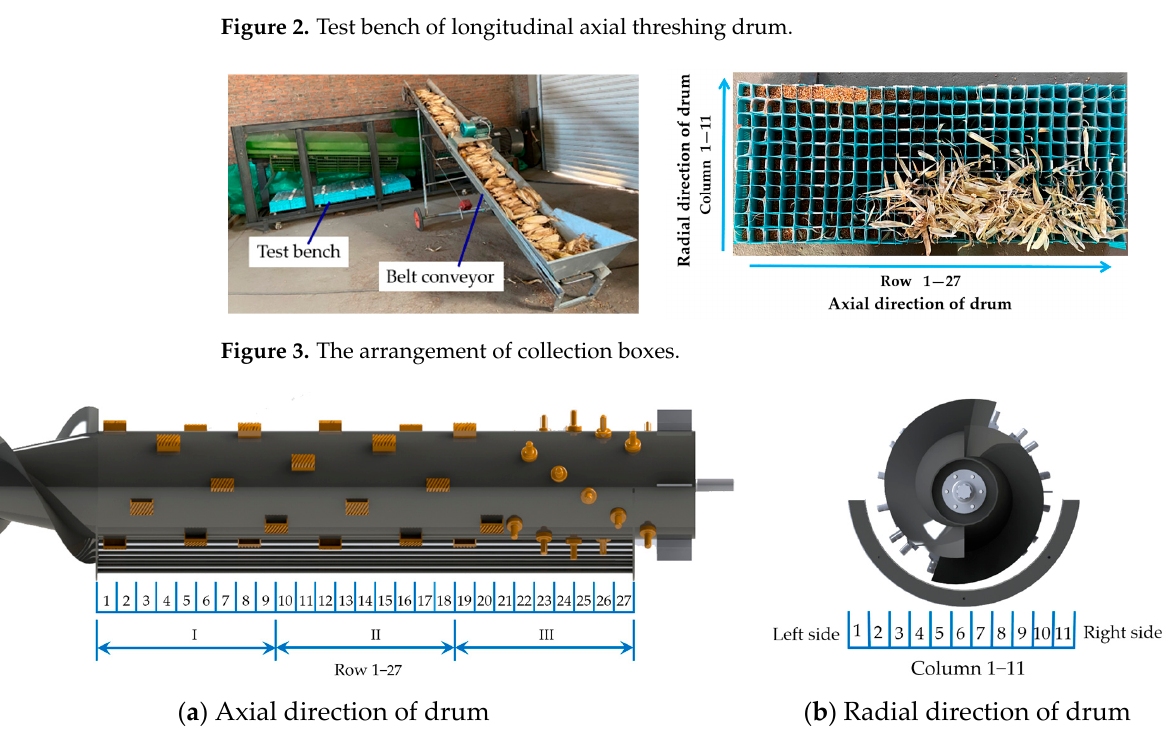
Figure 4. Schematic diagram of axial ( a ) and radial ( b ) arrangement of collection boxes.